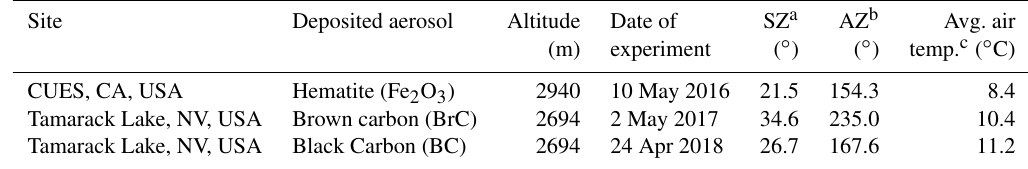
Table 1. Overview of deposition and HCRF collection information. Site